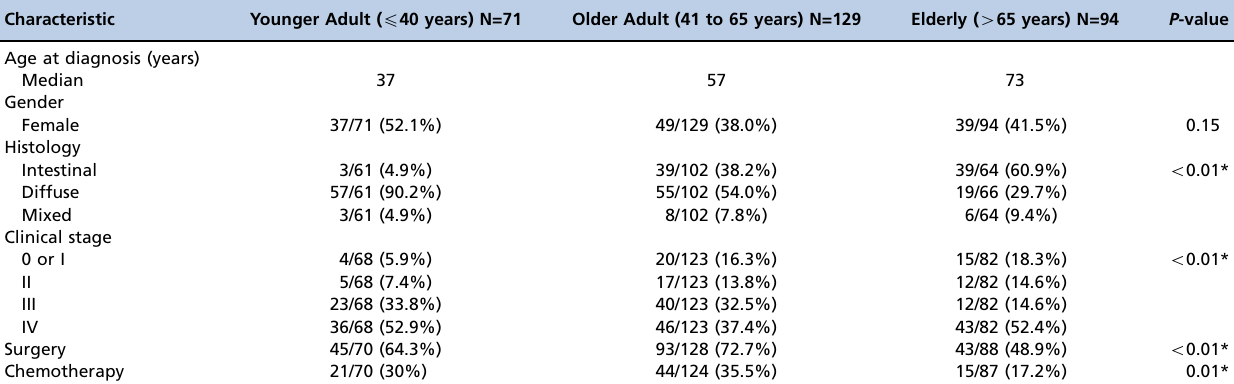
Table 1 - Clinicopathological features of gastric cancer patients according to age group.